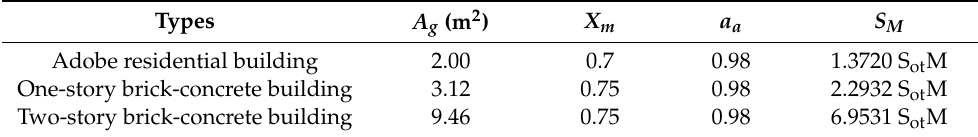
Table 15. Simplified formula of the monthly solar e ffi cient heat S M for each residential